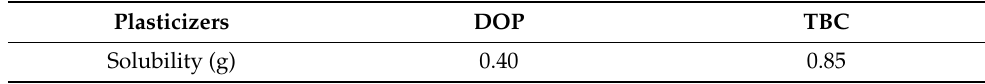
Table 3. Solubility of Zn(Arg) 2 in 10mL DOP and